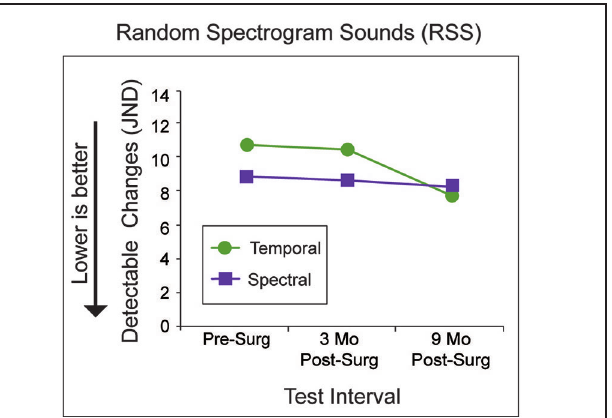
FIGURE 5 | P1’s minimum detectable changes (JND; y -axis) for temporal (green circles) and spectral complexity (purple squares) are indicated for each test interval ( x -axis) . Lower JNDs reflect better